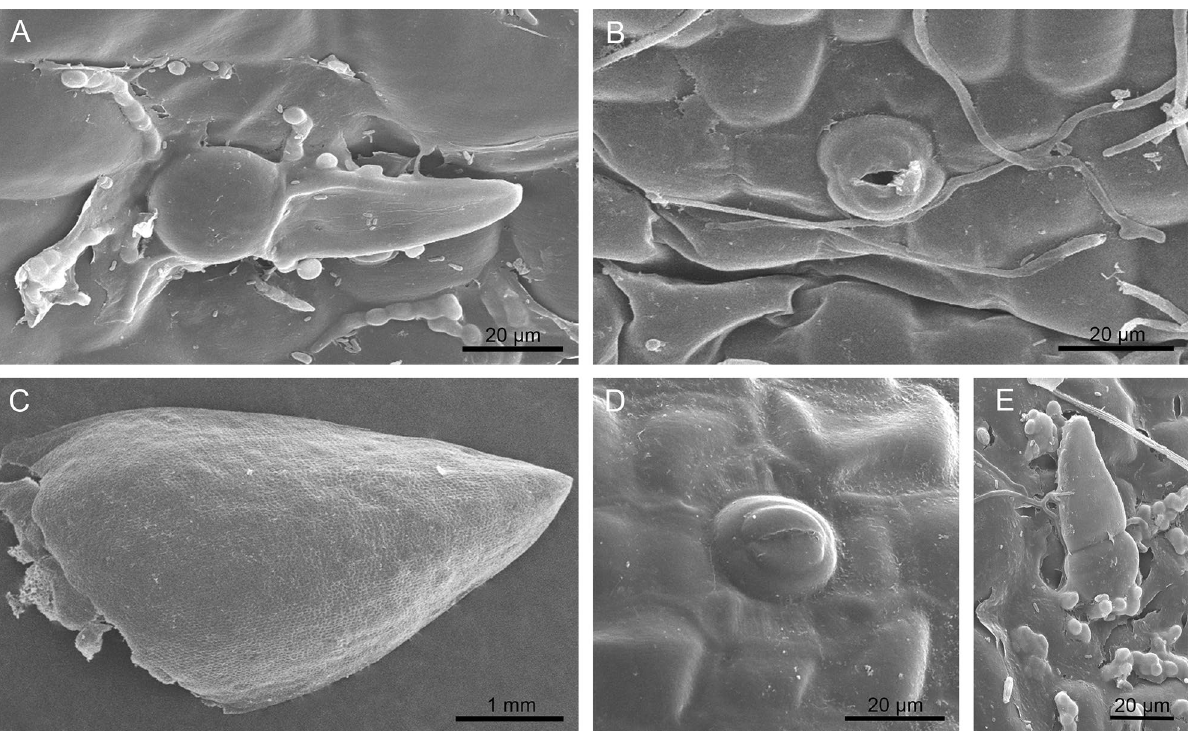
Figure 2. Micromorphological studies (SEM): ( A ) Dorsal sepal: two-celled trichomes scattered on the outer (upper, abaxial) surface, covered by remnants of secretions. Fungal spores and hyphae were noticed on the surface; ( B ) Dorsal sepal: the glabrous inner (lower, adaxial) surface at the apex with a paracytic type of stomata. Some fungal hyphae also present on the surface; ( C ) Lateral sepal: glabrous outer surface with some secretory residues; ( D ) Lateral sepal: glabrous outer surface with paracytic type of stomata; ( E ) Lateral sepal: the two- celled trichomes with secretory residues on the outer surface. Fungal spores and hyphae were also